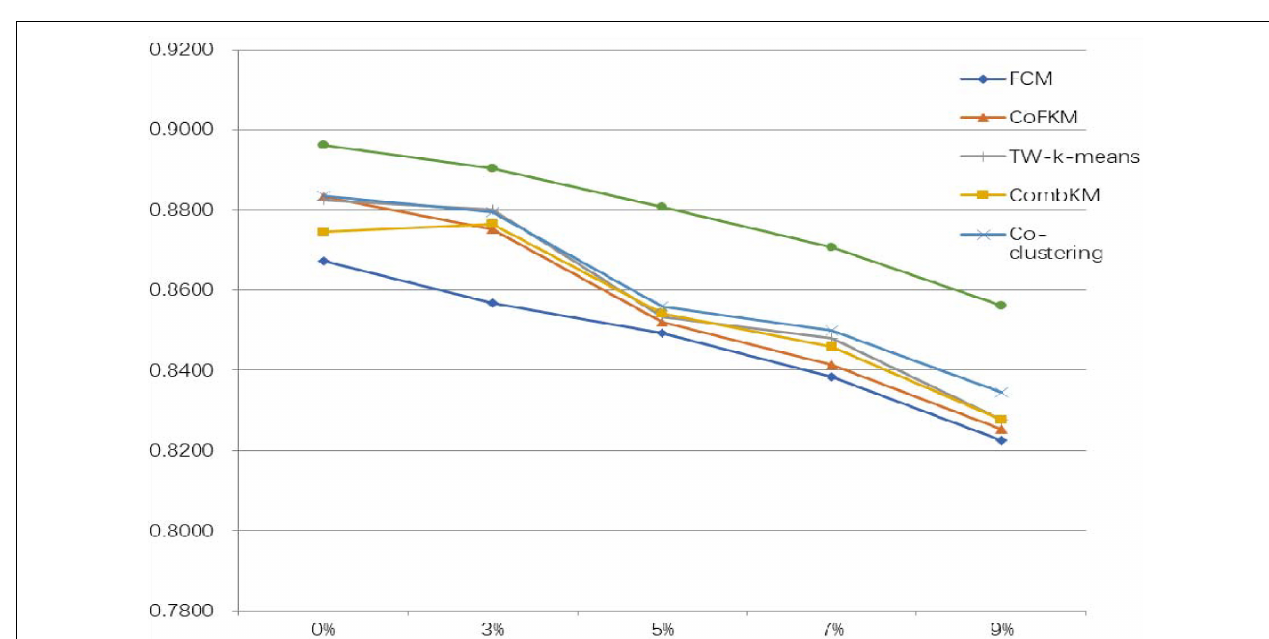
FIGURE 6 | JS indicator drop rate of each algorithm.